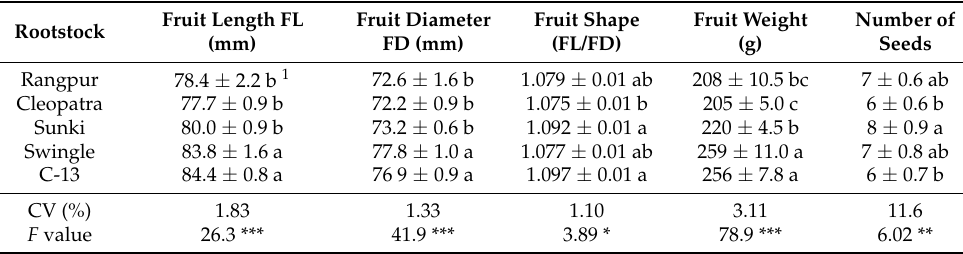
Table 3. Nine-season average fruit quality of ‘Shamouti’ sweet orange trees grafted on different rootstocks grown in Londrina, state of Paran á , Brazil, from 2009 up to 2017. Rootstock